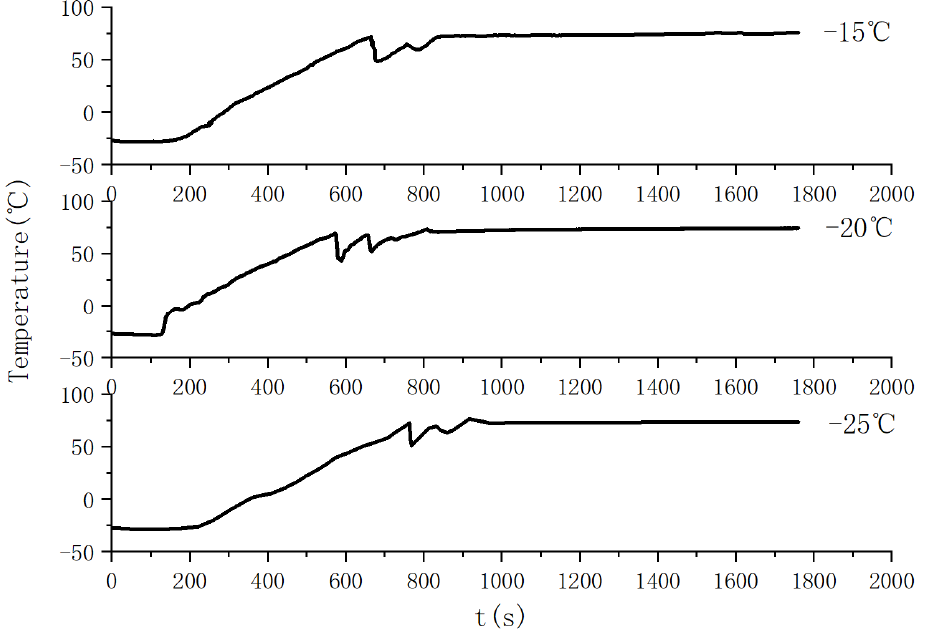
Figure 2. Graph of the temperature change in Stack A with time.